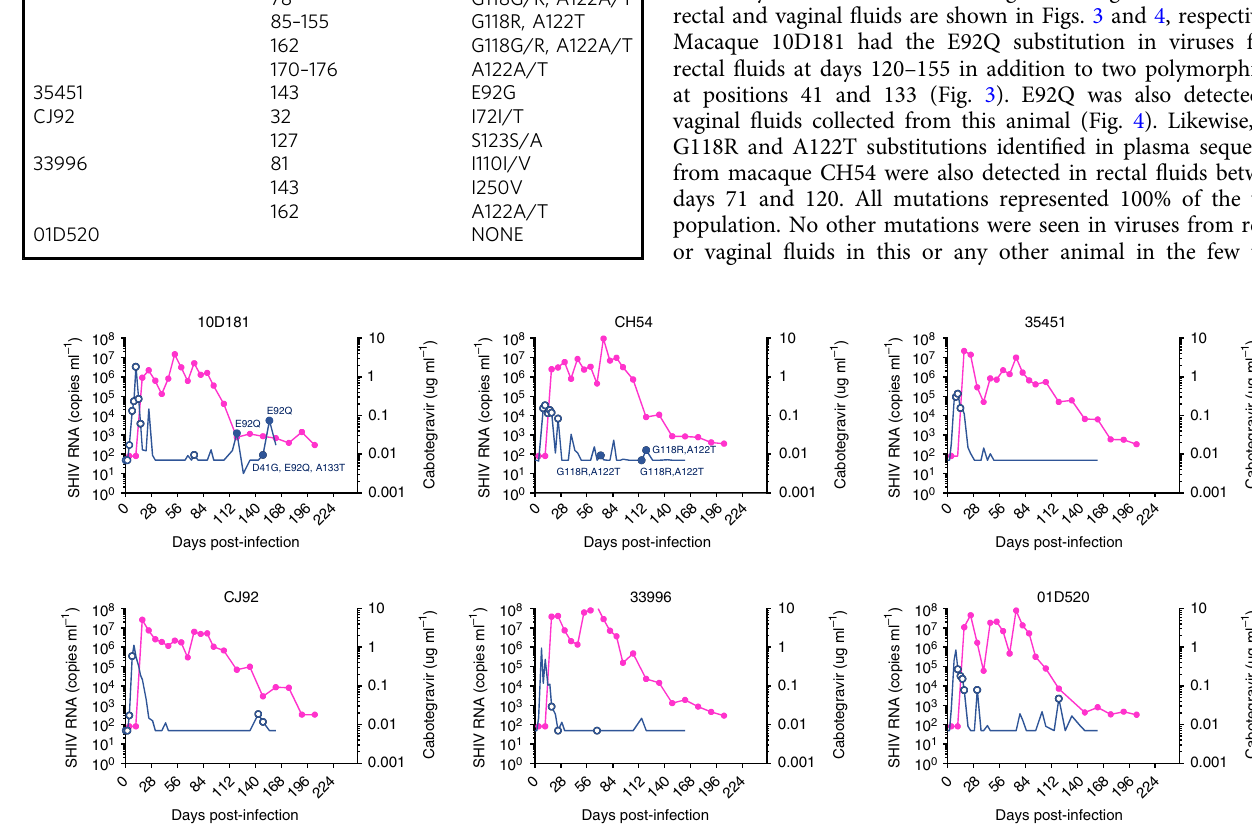
Fig. 3 Integrase mutations identi fi ed in viruses from rectal fl uids. The magenta line indicates the concentrations of cabotegravir and the blue line SHIV RNA levels. Circles denote time points that were successfully ampli fi ed and genotyped. Closed circles denote time points with integrase mutations, which are also indicated. Source data are provided as a Source Data fi le